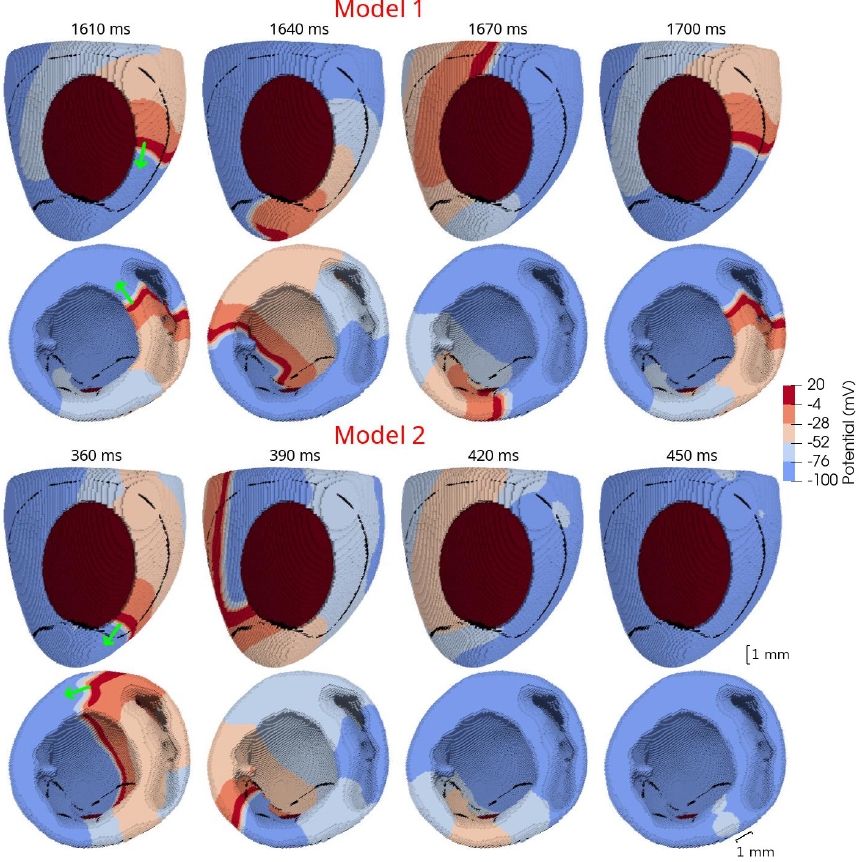
Figure 9. Scroll waves rotating around a post-infarction scar in anatomical models of the rat ventricles. A 1 mm spatial scale bar is shown on the bottom right. The voltage color scale is the same as in Figure 8. The post-infarction scar is colored in dark red. A black line around the scar area indicates the boundary between the border zone and normal tissue. Color scale for transmembrane potential is given on the middle right. Green arrows in the first column indicate the direction of